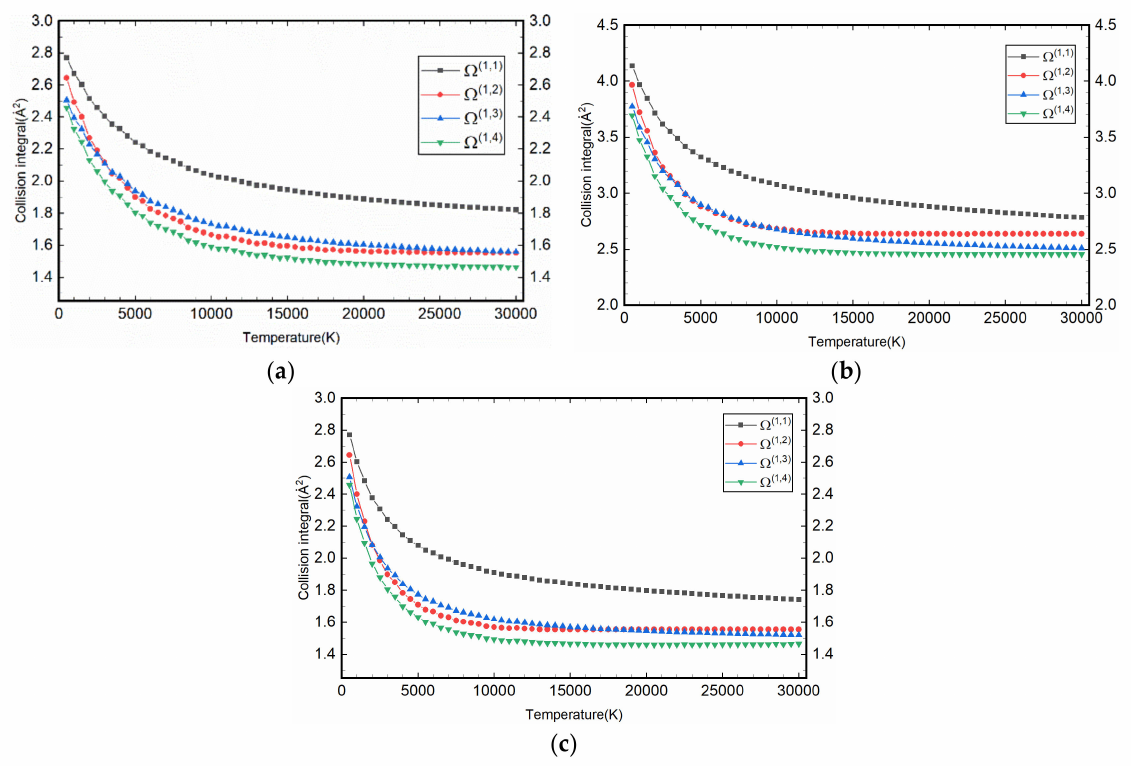
Figure 4. The curve of collision integrals as a function of temperature. ( a ) Mg-C; ( b ) Mg-Mg; ( c )